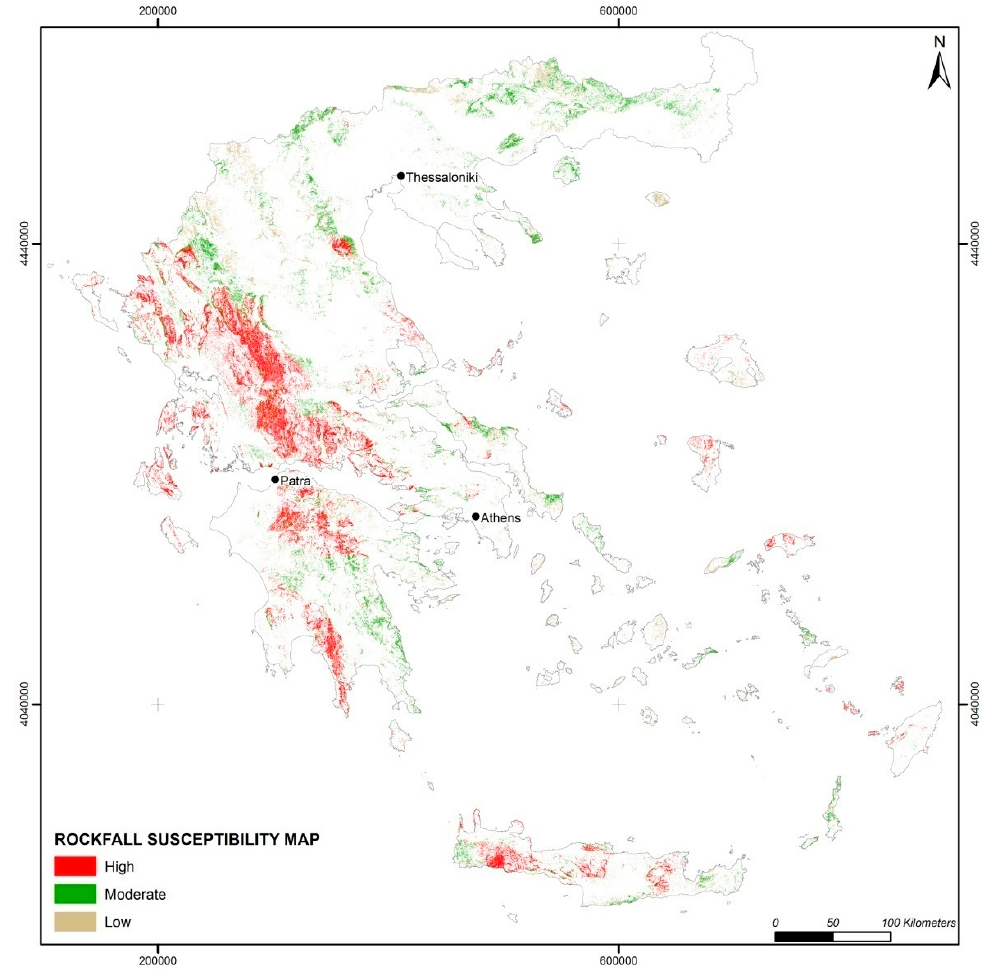
Figure 11. Rockfall susceptibility map of Greece.